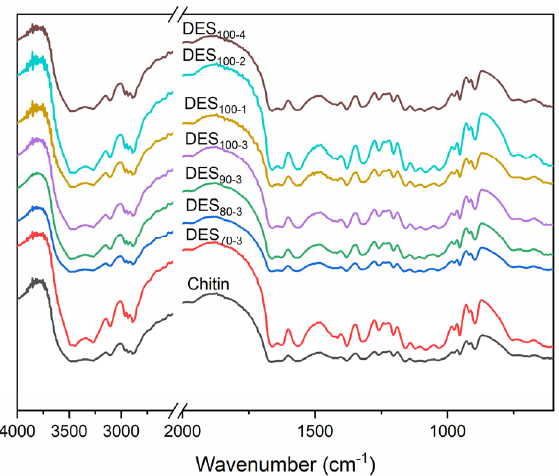
Figure 2. FT-IR spectra of pristine chitin and ChNCs prepared using DES under different reaction